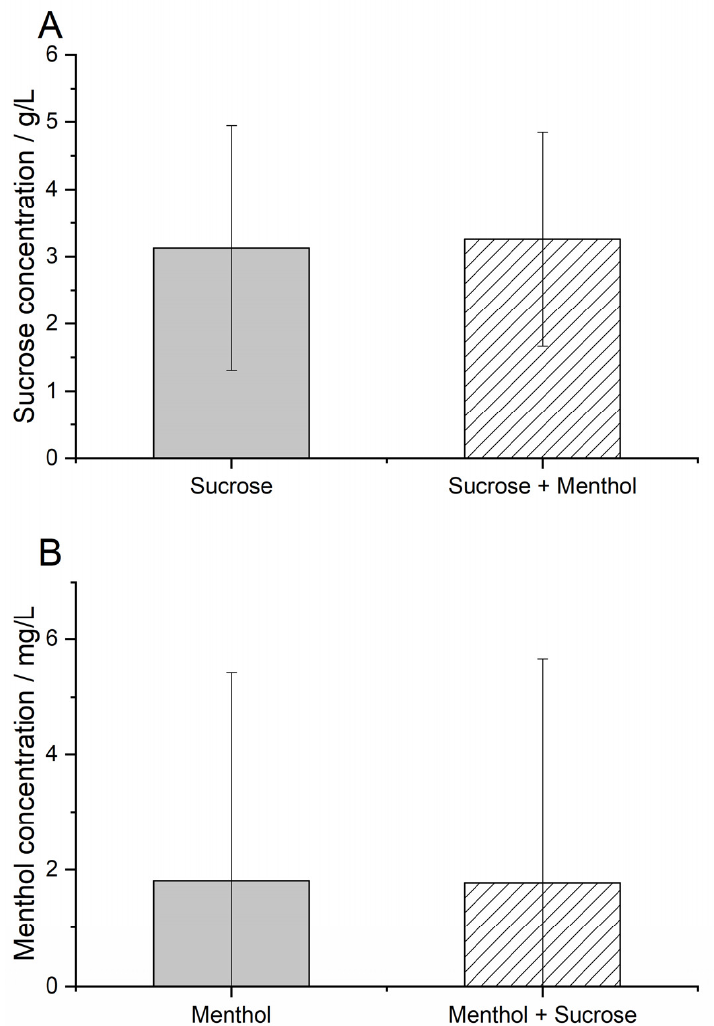
Figure 2. Recognition thresholds for ( A ) sucrose in water and menthol solution, and ( B ) menthol in water and sucrose solution, with geometric standard deviation, rated by n = 32 participants.